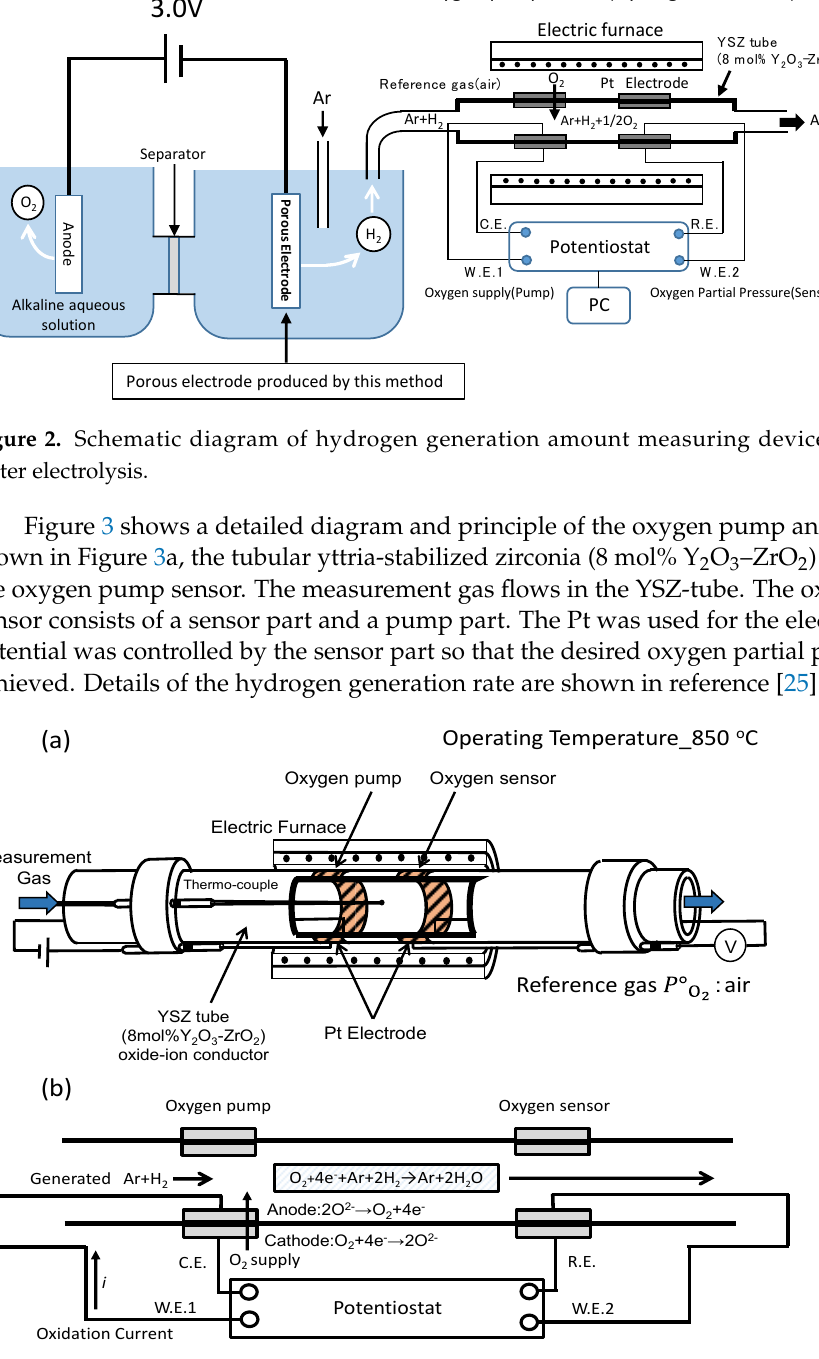
Figure 3. Schematic diagram of oxygen pump sensor for hydrogen content measurement. ( a ) Overall view, ( b ) Principle diagram.